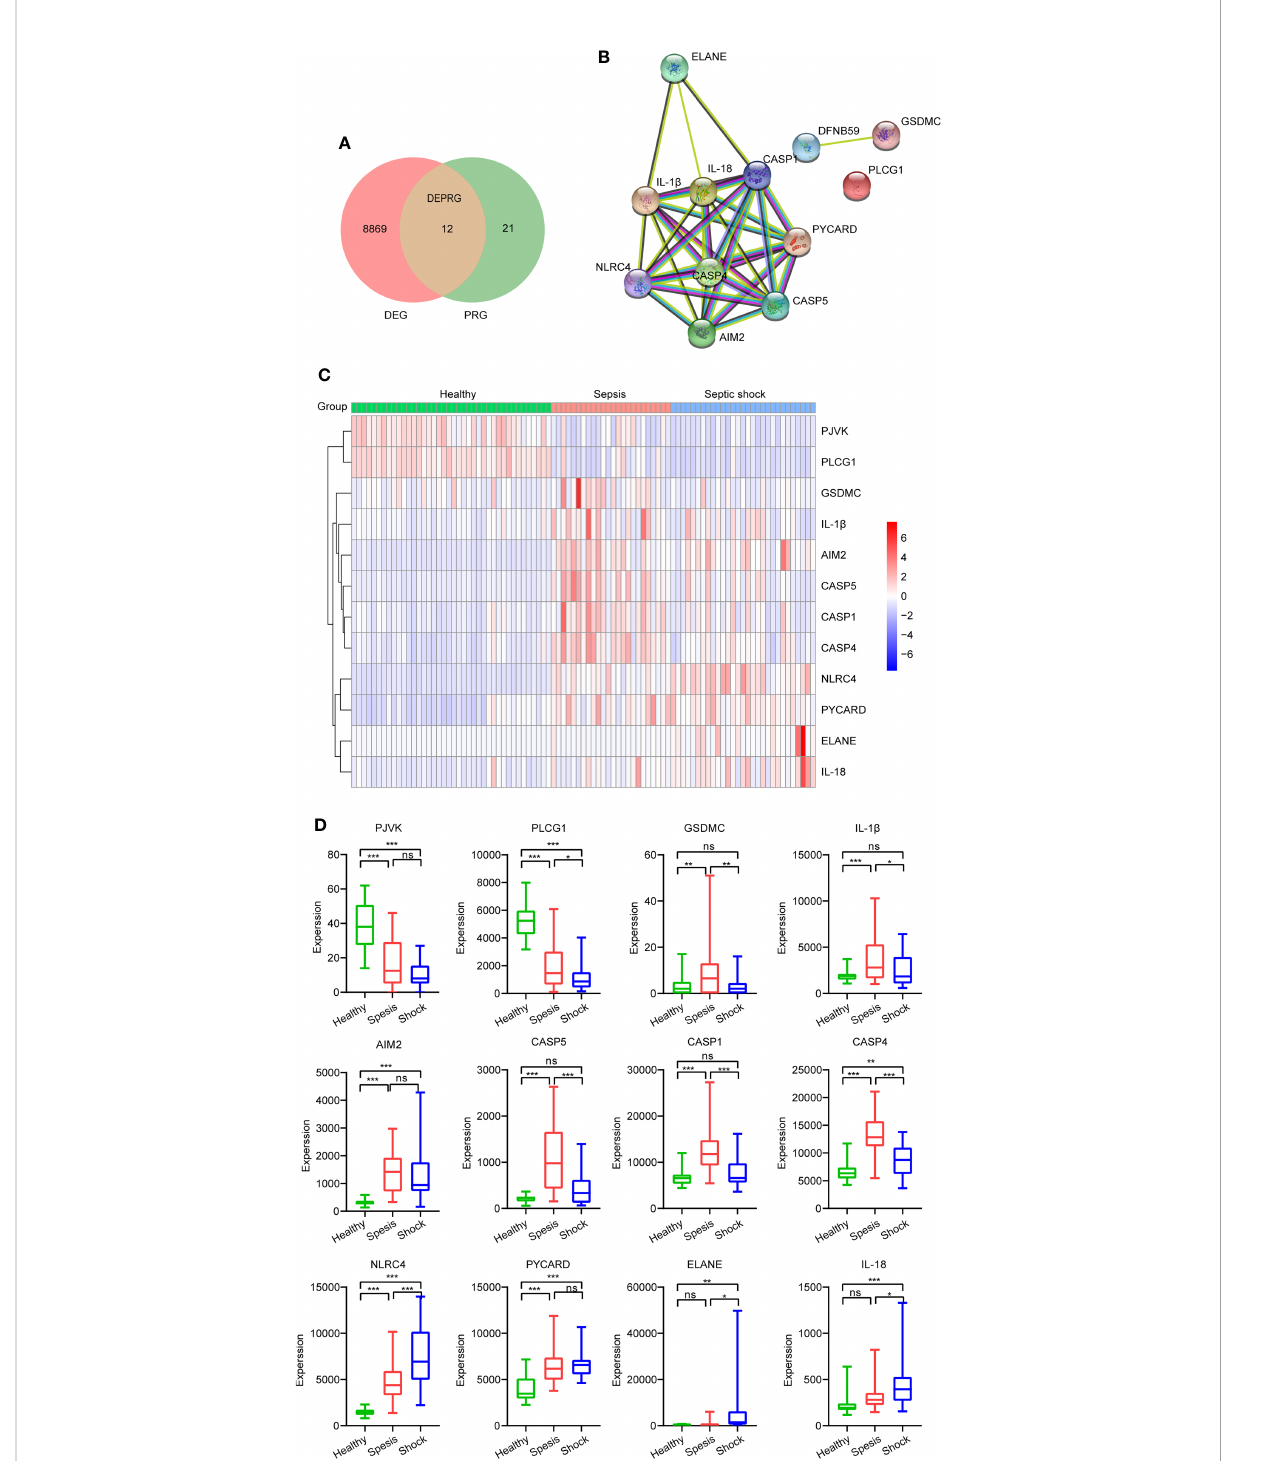
FIGURE 2 Identi fi cation of DEPRGs between healthy and sepsis. (A) Venn diagram of DEGs and PRGs in GSE154918. (B) The PPI network shows the interactions of the 12 DEPRGs (interaction score = 0.7). (C) Heatmap of the 12 DEPRGs ’ expression of each sample. (D) Boxplot showing expression of each DEPRG in healthy, sepsis, and septic shock patients. * p < 0.05, ** p < 0.01, *** p < 0.001. DEPRGs, differentially expressed pyroptosis-related genes; DEGs, differentially expressed genes; PPI, protein – protein interaction. ns is short for no signi fi